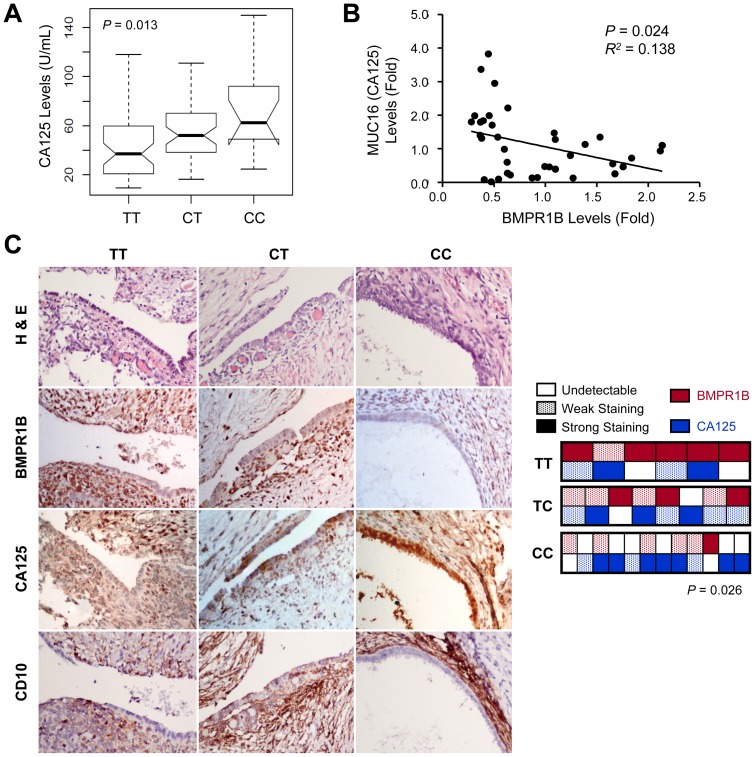
Genotypic variants presented at miR-125b binding site correlated with varied CA125 levels in patients.A. Serum CA125 levels in endometriosis patients were grouped by their rs1434536 genotypes. Bold lines indicate median values of CA125 levels in each genotype group. Notch regions define 95% confidence interval estimations of median values. B. Gene expression levels of BMPR1B and CA125 (MUC16) in ectopic endometrial tissues were measured by quantitative PCR for correlation study. C. Immunohistochemistry (IHC) staining was performed on ectopic endometrial tissues from patients. Anti-CD10 staining, a stroma cell-specific marker, serves as the reference to normalize immunointensity. Ectopic endometrium samples represented patients with rs1434536 genotype of CC, CT; and TT, as labeled on top of each column. A total of 6, 8 and 12 samples from tissue microarrays could be defined as TT, CT and CC genotype groups, respectively, and their expression levels for BMPR1B and CA125 were scored as described in method section (right panel). Box plot and ANOVA P value calculation were performed in R software suite.